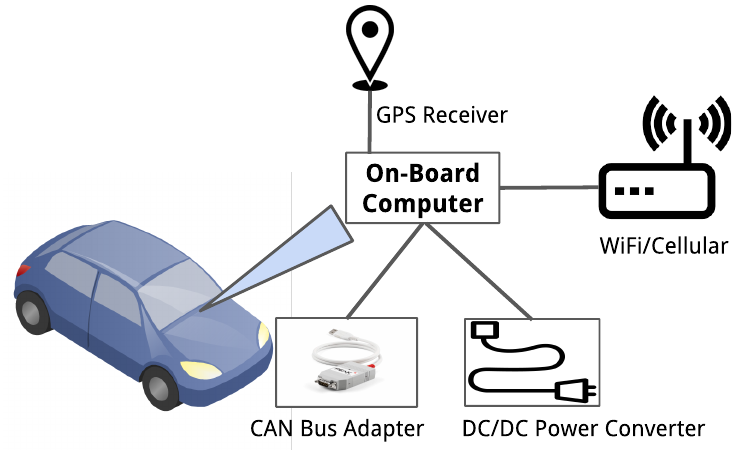
Figure 4. Basic hardware components of the